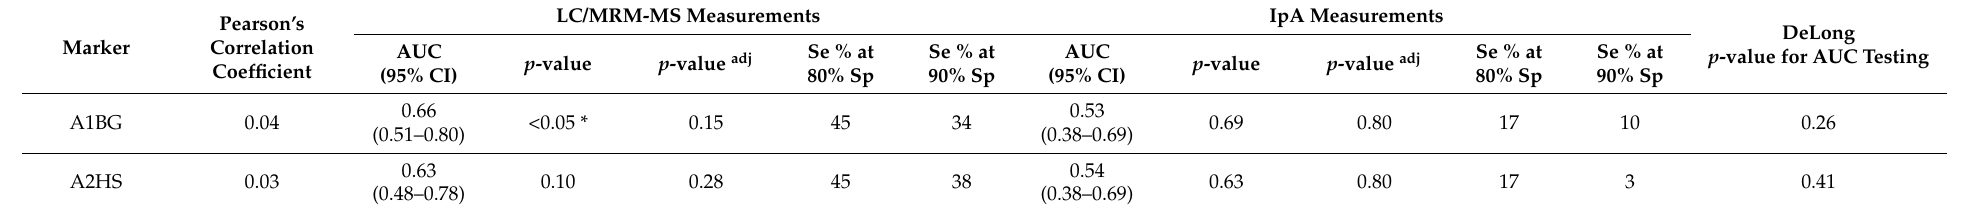
Table 5. Diagnostic performance of 14 biomarkers overlapping between LC/MRM-MS and IpA measurements for detecting CRC cases from participants in screening